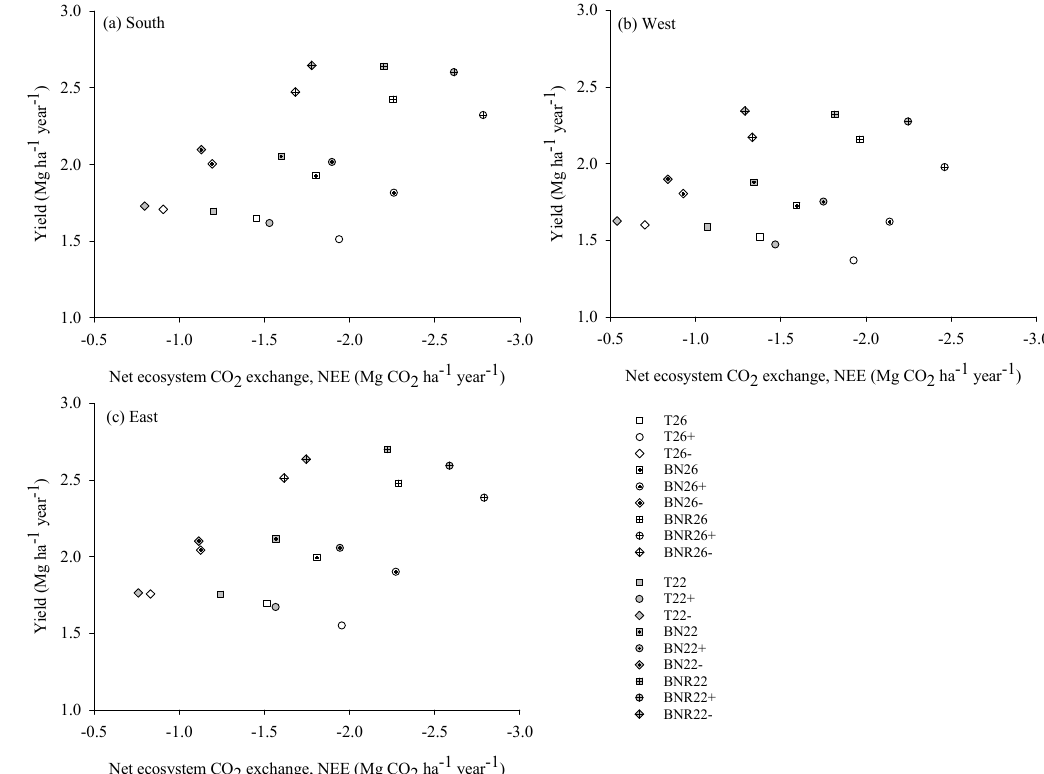
Figure 5. Mean annual net ecosystem CO 2 exchange, NEE (Mg CO 2 ha − 1 year − 1 ) against harvested biomass yield (Mg ha − 1 year − 1 ) over the 40 ‐ year period for different management scenarios and three different harvest intensities including timber (T), timber and logging residues, without (BN) and with coarse roots and stumps (BNR) in the final felling made at DBH of 26 cm and 22 cm in southern ( a ), western ( b ) and eastern ( c ) sub ‐ regions of Finland. For the key of the management scenarios, see Table 1.